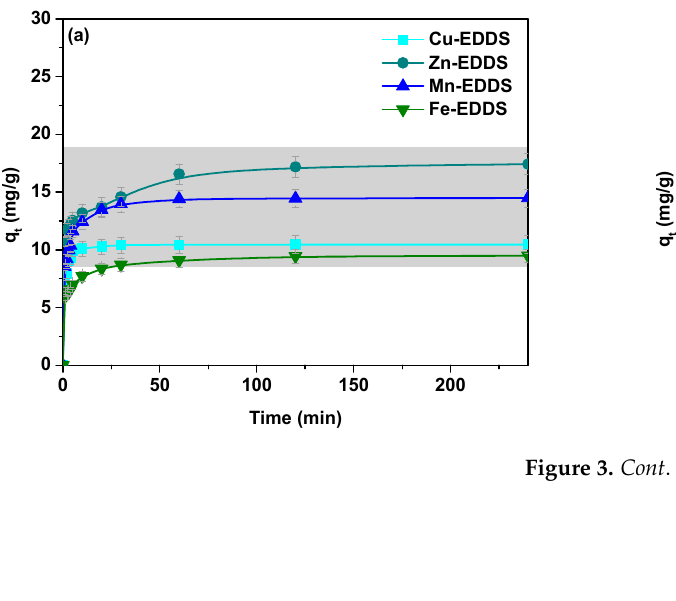
Figure 2. Effect of pH on the sorption capacity for the Cu(II) complexes with EDDS on THA, ZH and AH.